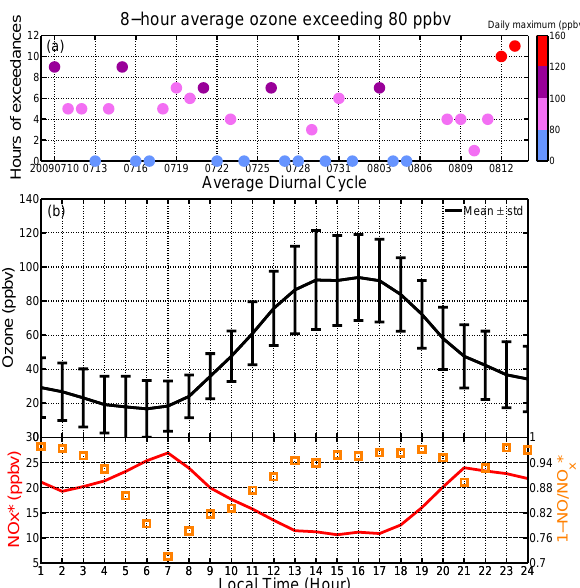
Fig. 2. (a) The number of hours in which running 8-h average ozone concentrations exceeding 80ppbv on each day. Color bar gives the daily maximum 8-h average ozone concentrations; (b) Average di- urnal cycle of ozone and NO x * during the campaign based on 1-h averages.